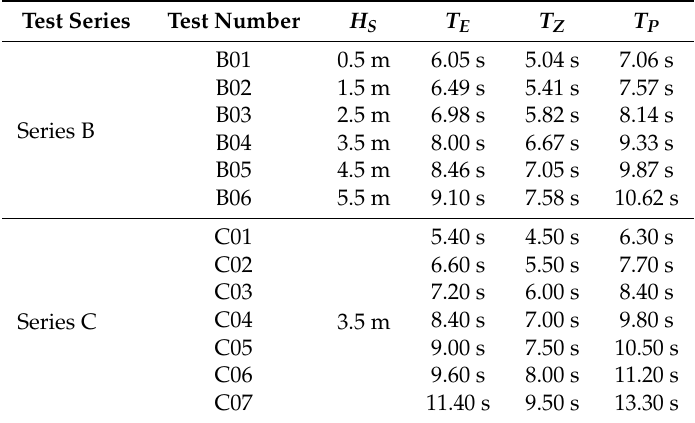
Table 2. Wave conditions for the two irregular wave series (data in prototype values).